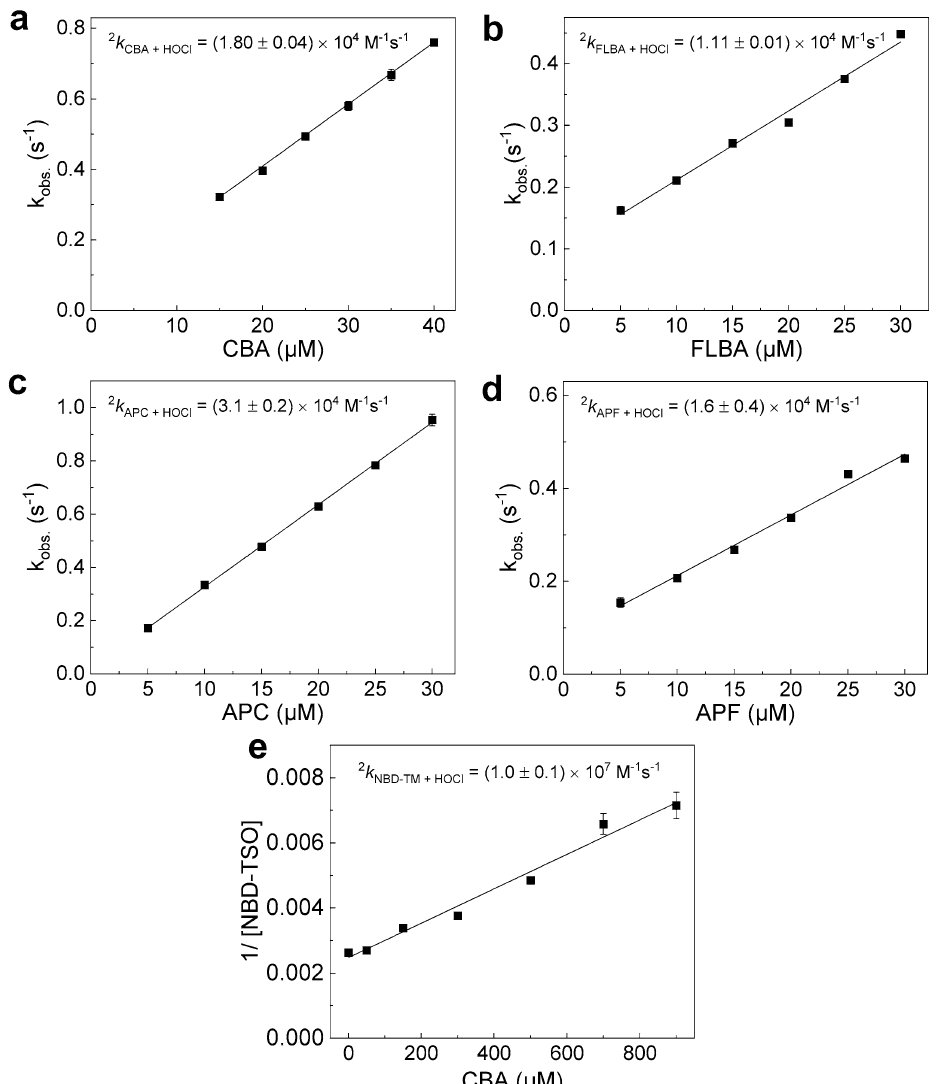
Figure 4. ( a ) The dependences of the pseudo-first-order rate constants of the reaction between CBA and HOCl on the initial concentration of CBA. Reaction mixtures contained 1 µM HOCl, 50 mM phosphate buffer (pH 7.4), 15–40 µM CBA. ( b ), ( c ), and ( d ) same as ( a ) but incubation mixtures contained FLBA (5–30 µM), or APC (5–30 µM), or APF (5–30 µM), instead of CBA. ( e ) The relationship used to determine the rate constant between HOCl and NBD-TM. The solid line in the panel ( e ) represents the linear fitting according to the Eq. (4). Incubation mixtures contained 50 mM phosphate buffer (pH 7.4), 0.5 µM HOCl, 0–900 µM CBA, and 1.5 µM NBD-TM. The R-square parameter for the linear fittings was at least 0.98 or higher. The observed non-zero intercepts are attributed to the slow decay of HOCl in the presence of organic solvent. (Each panel is a representative result of three independent experiments, points represent means ± S.D.; rate constants were calculated on the basis of three independent experiments and are given as mean ±